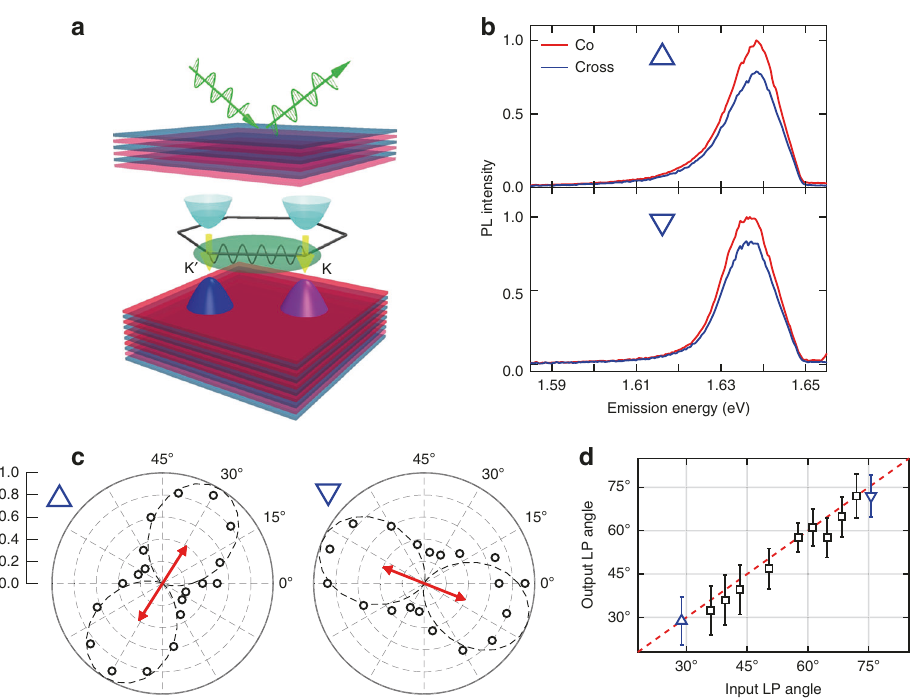
Fig. 2 Observation of polariton valley coherence. a Schematic of coherent valley polariton states. A linearly polarized pump generates a coherent superposition of polaritons arising from the K and K ′ valley. The polariton radiatively decays emitting a linearly polarized output. b PL spectrum of lower polariton when the excitation and detection polarization are aligned (Co-) and perpendicular (Cross-). c Normalized lower polariton PL intensity as a function of detection angle for given input linear polarization (red arrow). The dashed lines are fi ttings to extract the orientation of output polarization. Baseline (unpolarized part) has been subtracted before normalization. 0.0 and 1.0 stand for the central and outermost contour of the polar diagram, respectively. d Relationship between output and input linearly polarized (LP) angles. Dashed line is a linear fi t with unity slope, which indicates the lower polariton PL has aligned linear polarization with the pump. Errorbars are extracted from least square fi tting